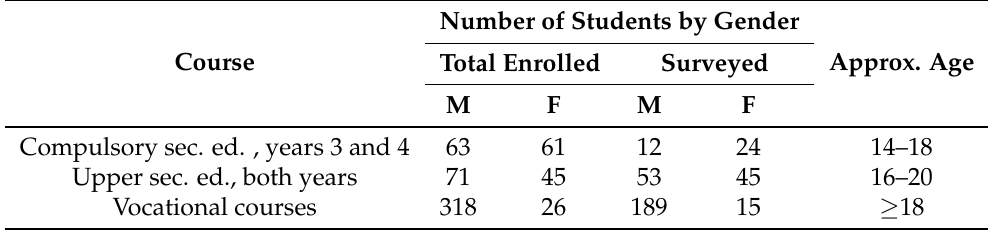
Table 1. Distribution of students per course in science and technology specialties, where the survey was undertaken. Number of enrolled/surveyed and approximate